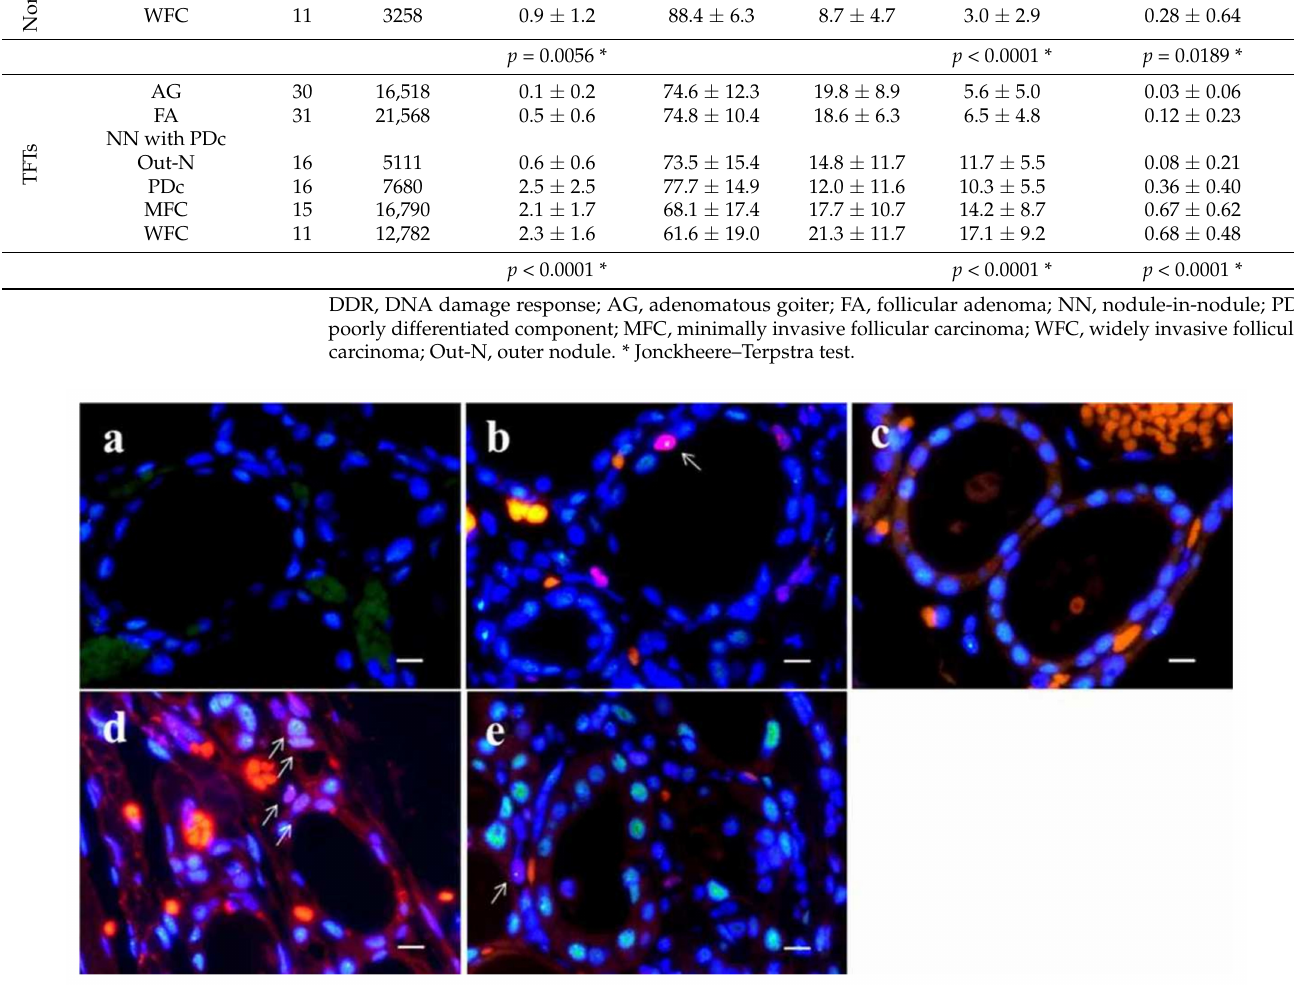
Figure 5. Dual-color immunofluorescence for TP53-binding protein 1 (53BP1) (green) and Ki-67 (red) in normal thyroid follicle surrounding follicular tumors. Adenomatous goiter ( a ); follicular ade- noma ( b ); nodule-in-nodule appearance tumor with poorly differentiated component ( c ); minimally invasive follicular carcinoma ( d ); and widely invasive follicular carcinoma ( e ). Arrows in ( b , d , e ) indicate double-positive types. The scale bars indicate 10 µ